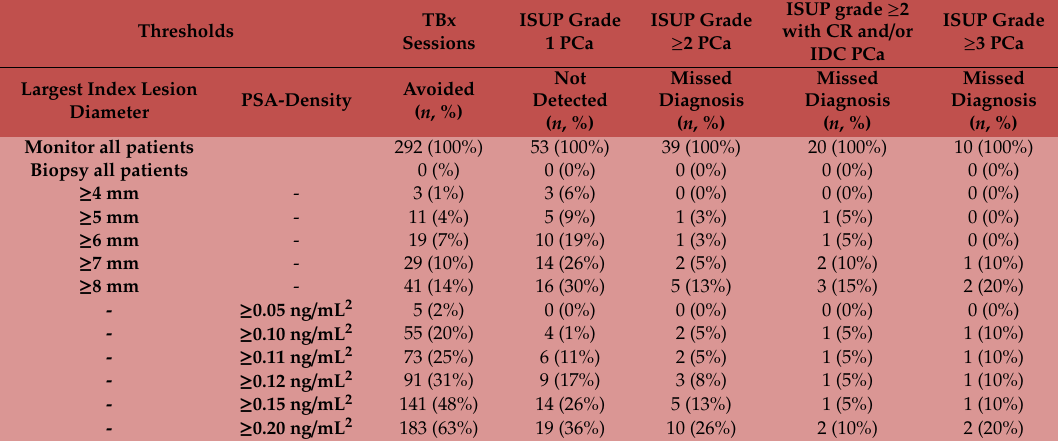
Table 4. Summary table of the avoided targeted biopsy sessions and prostate cancer diagnoses missed when using the largest index lesion diameter or PSA density as a stratification